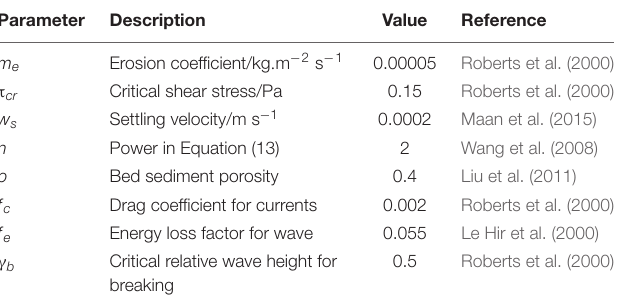
TABLE 1 | Descriptions and settings for model